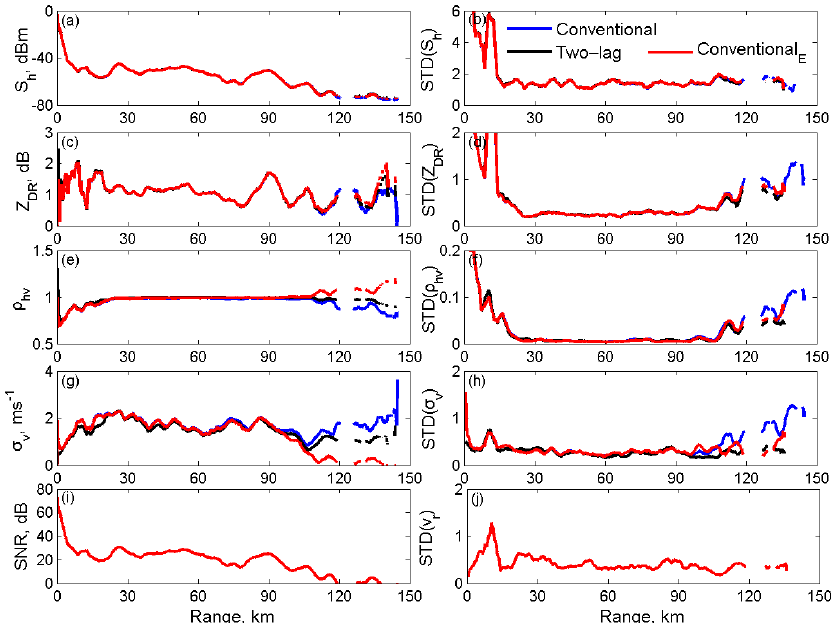
Figure 4. Comparison between conventional estimators and two-lag estimators for radial A. Four rows show S h , σ v , Z DR , ρ hv and their standard deviation, respectively. SNR and STD(v r ) are given in the fifth row. ( a ) S h ; ( b ) STD(S h ); ( c ) Z DR ; ( d ) STD(Z DR ); ( e ) ρ hv ; ( f ) STD( ρ hv ); ( g ) σ v ; ( h ) STD( σ v ); ( i ) SNR; and ( j ) STD(v r ).